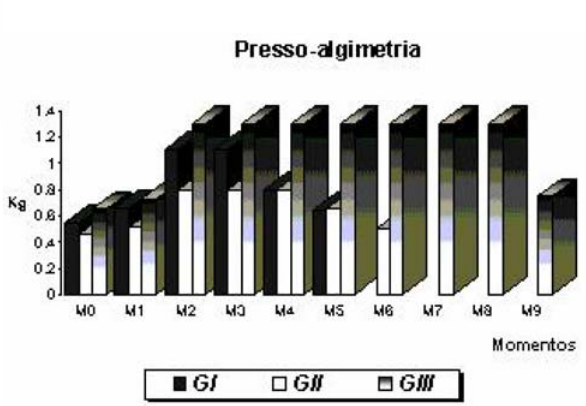
FIGURA 4 – Valores medianos da pressoalgimetria em kg, de cães (n=10), tratados com 1 mg/kg de levomepromazina, 0,2 mg/kg de midazolam e 15 mg/kg de quetamina (GI), pré-tratados com butorfanol (G II) ou pela buprenorfina (G